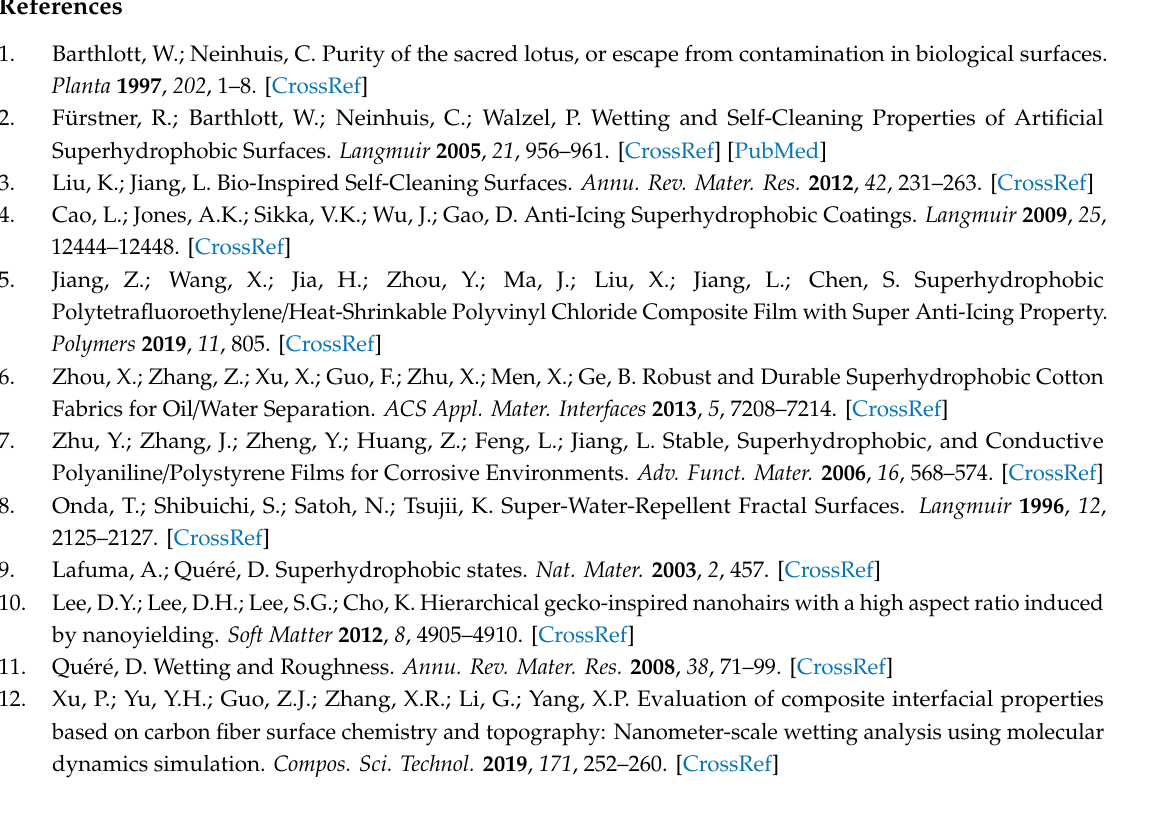
Figure S1: Photographs of spin-coated samples prepared with GOTMS:APTES molar ratios, Table S1: DI water and diiodomethane contact angles and calculated surface energies, Figure S2: XPS spectra and analysis of spin-coated siloxane resins with FAS, Table S2: Pencil hardness of spray-coated surfaces obtained under di ff erent coating conditions, Figure S3: SEM images of NPs after sonication of solution for 1, 30, and 90 min, Figure S4: SEM and confocal laser scanning microscope images of spray-deposited NPs on Si wafers, Figure S5: XPS spectra of coatings with NP and elemental composition, Figure S6: TGA curve of the siloxane resin in a nitrogen atmosphere, Figure S7: Photographs of CAs changes while staying water droplets on the superhydrophobic surface for 0, 5, 10, 15, and 20, and 30 min, Movie S1: Drops of water dyed with methylene blue on superhydrophobic surfaces tilted at 15 ◦ , Movie S2: Drops of water dyed with methylene blue on patterned superhydrophobic surfaces tilted at 15 ◦